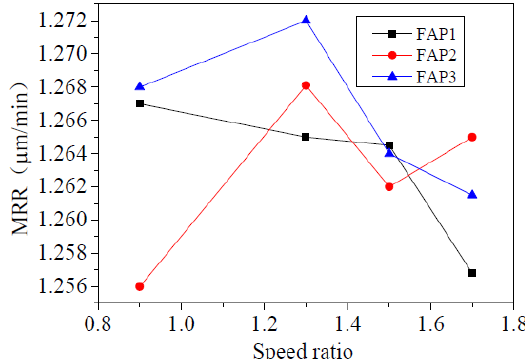
Figure 16. MRR vs. speed